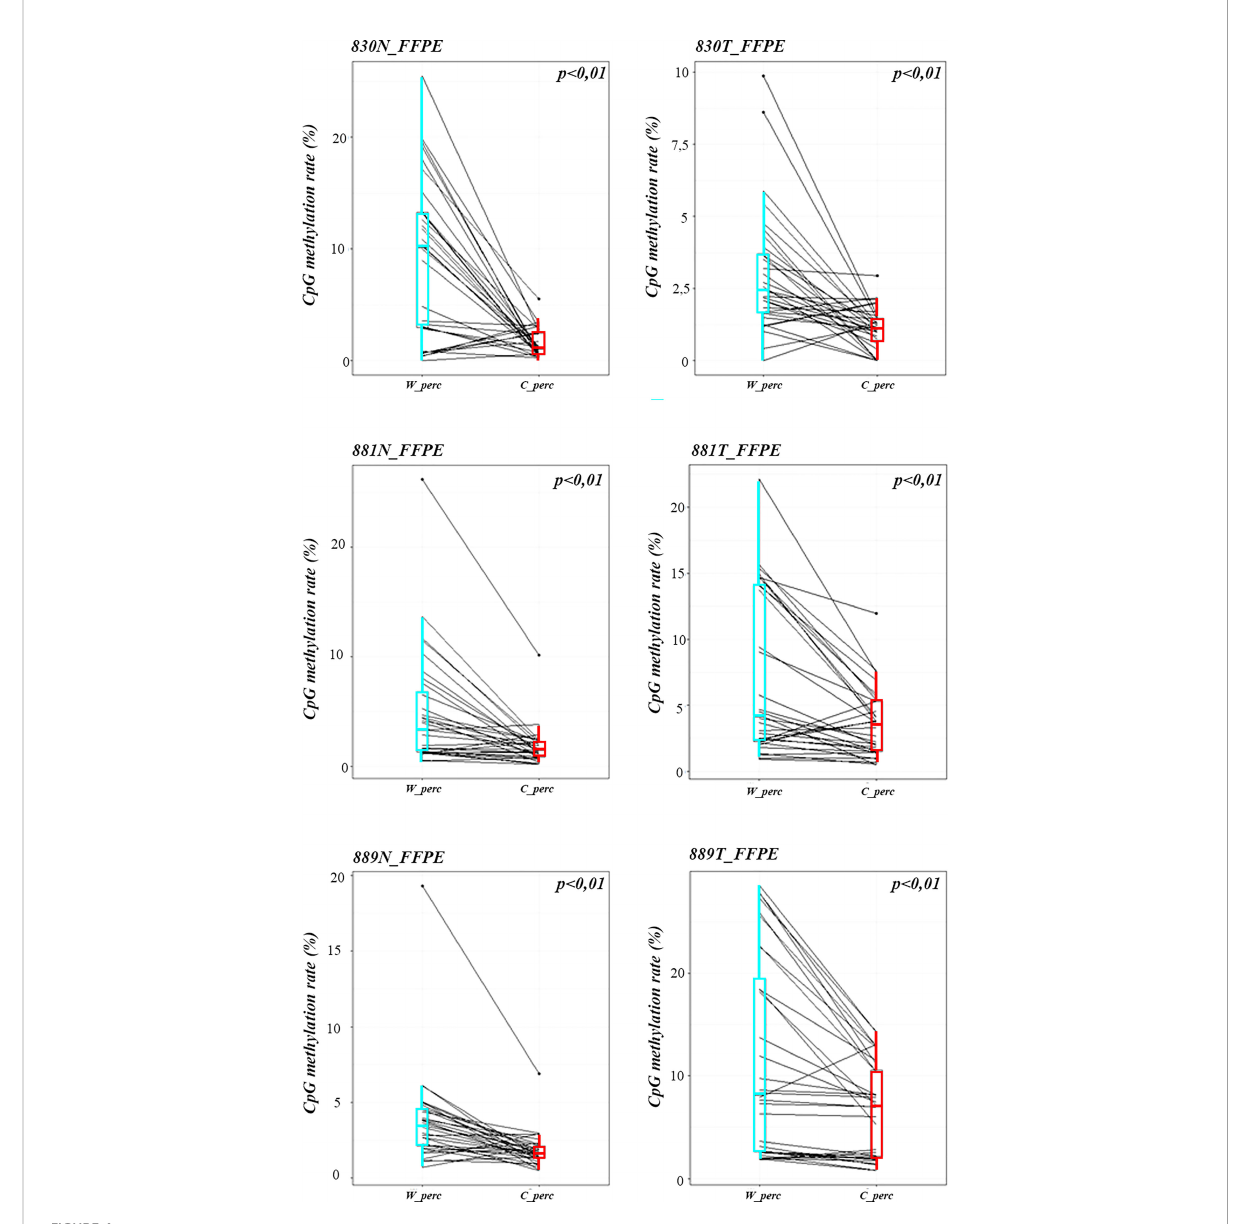
FIGURE 4 Strand speci fi c distributions of CpG methylation in samples using OPERA_MET-A panel. The average percent of global CpG methylation at RASSF1A gene (target_CpGs) in paired non-neoplastic and tumor tissues of FFPE samples 830, 881, 889. Global % CpG methylation at W strands is in light blue boxplots, at C strands in red boxplot ( Wilcoxon signed-rank test